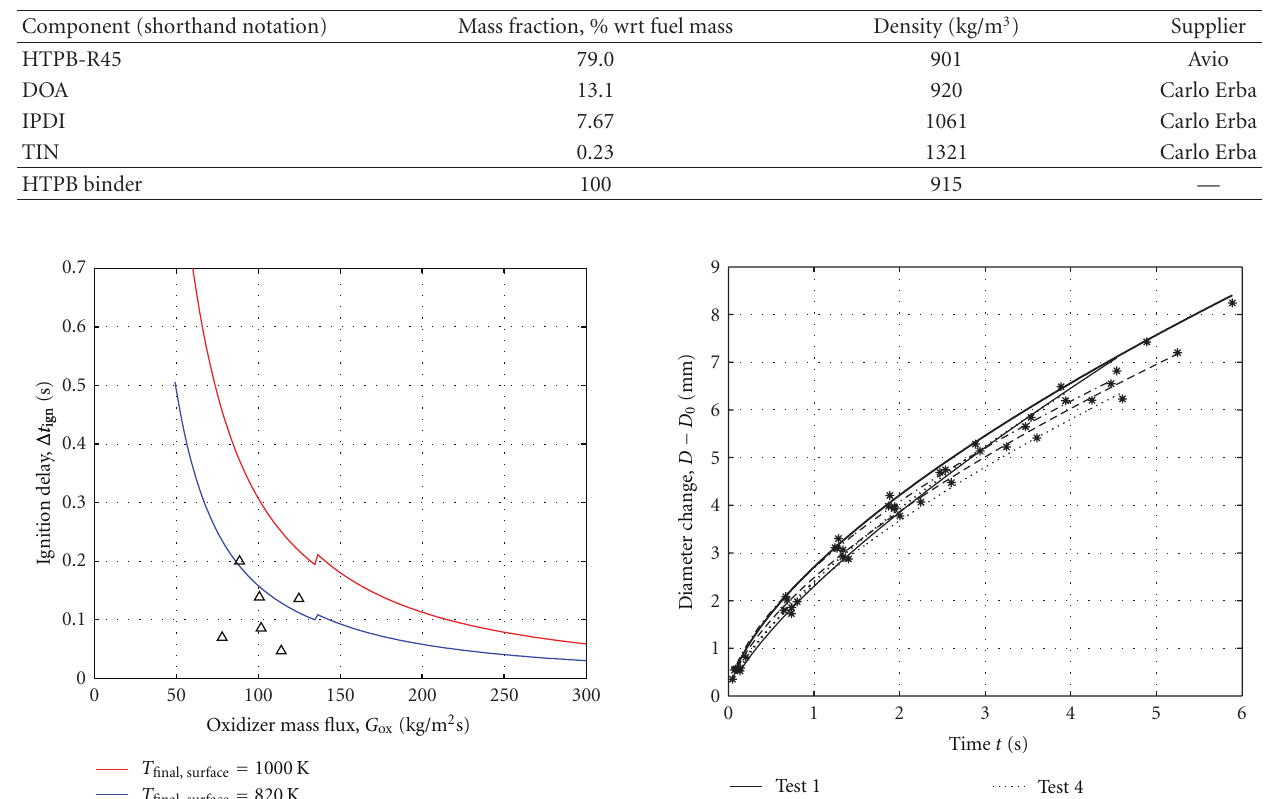
Table 1: Baseline (HTPB) solid fuel formulation and ingredients density.